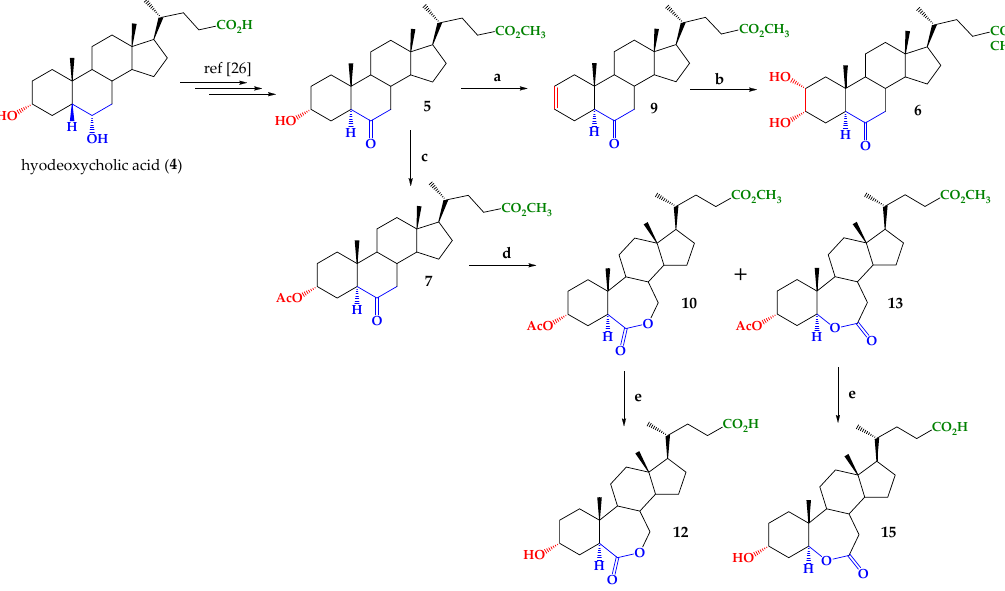
15% (aqueous solution)/CH 3 OH, reflux, 1 h. Derivative 5 has been previously reported [26]. r.t., 72 h.; ( c ) Ac 2 O/DMAP, CH 2 Cl 2 /py, r.t., 30 min.; ( d ) (CF 3 SO 2 ) 2 /H 2 O 2 /CHCl 3 , 0 °C, 24 h.; ( e ) K 2 CO 3